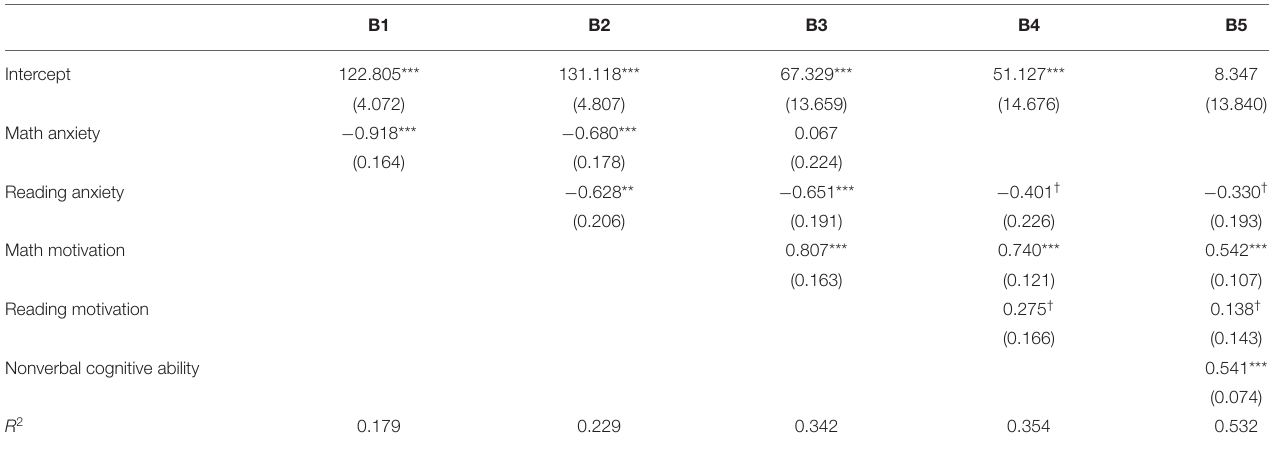
TABLE 4 | Taxonomy of models showing the relation between Broad Mathematics skills and within and across domain anxiety and motivation, and nonverbal cognitive ability ( n =